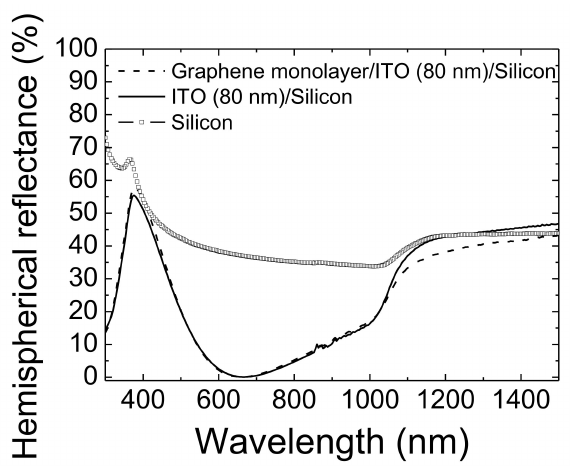
Figure 6. Total (hemispherical) reflectance spectra of hybrid transparent contact based on 80 nm-thick ITO layer coated silicon and a graphene monolayer on top (dashed line), 80 nm-thick ITO layer deposited on silicon (solid line) and the bare silicon (square